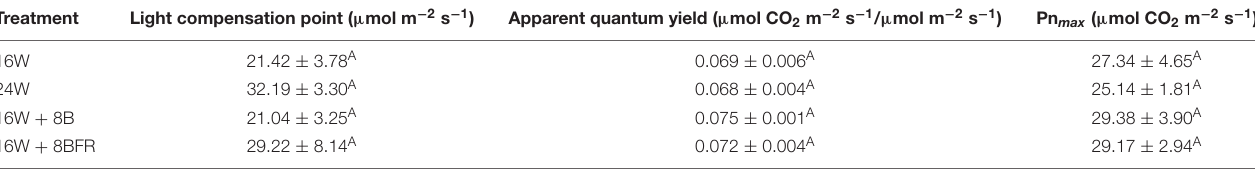
TABLE 2 | Summary of the major physiological parameters as determined by leaf light response curves ( Figure 4 ) from peppers grown under all treatments at 91 DIT. Treatment